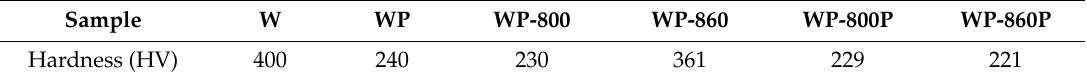
Table 3. The hardness of the Gr. 91 WM samples in di ff erent